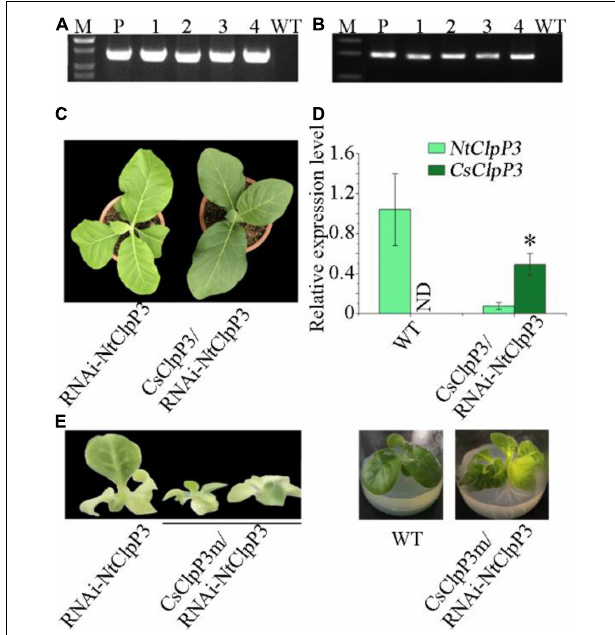
FIGURE 5 | Complementation of transgenic tobaccos with RNAi-NtClpP3 using CsClpP3 and CsClpP3m from chlorotic tea YJX. (A) PCR confirmation for the presence of the transgene cassette RNAi-NtClpP3. (B) PCR confirmation for the presence of the transgene CsClpP3 from tea YJX. (C) Green leaf recovery of transgenic tobacco carrying RNAi-NtClpP3 complemented with tea CsClpP3 . (D) Transcript levels of NtClpP3 and CsClpP3 in WT and complemented plants. (E) Leaf chlorosis phenotypes of 1-week-old and 6-week-old transgenic tobacco plants carrying RNAi-NtClpP3 complemented with tea CsClpP3m . ND, not detectable; one way-ANOVA analysis was performed using SPSS19 software. ∗ p <